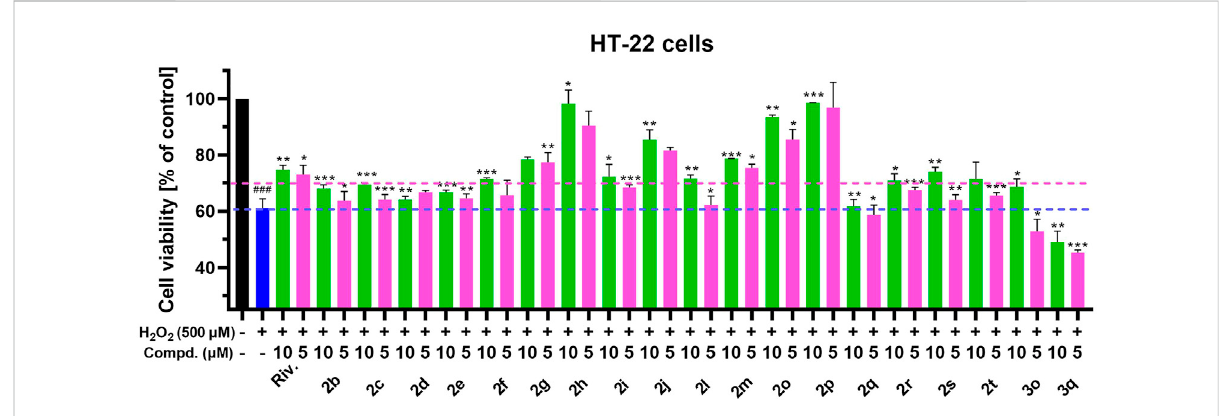
FIGURE 9 Cell viability was examined by MTT assay. Neuroprotective effects of tested compounds against the toxicity elicited by 500 μ M H 2 O 2 . HT-22